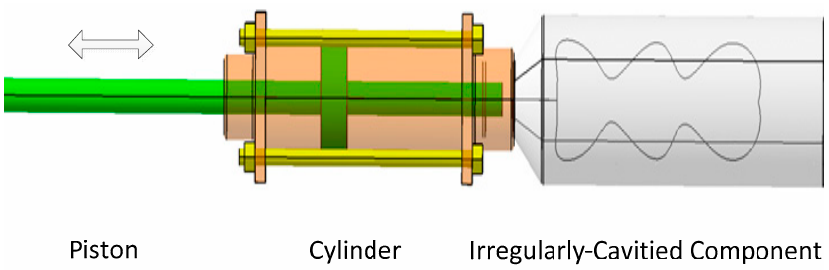
Figure 1. The volume detection principle schematic of irregular cavity